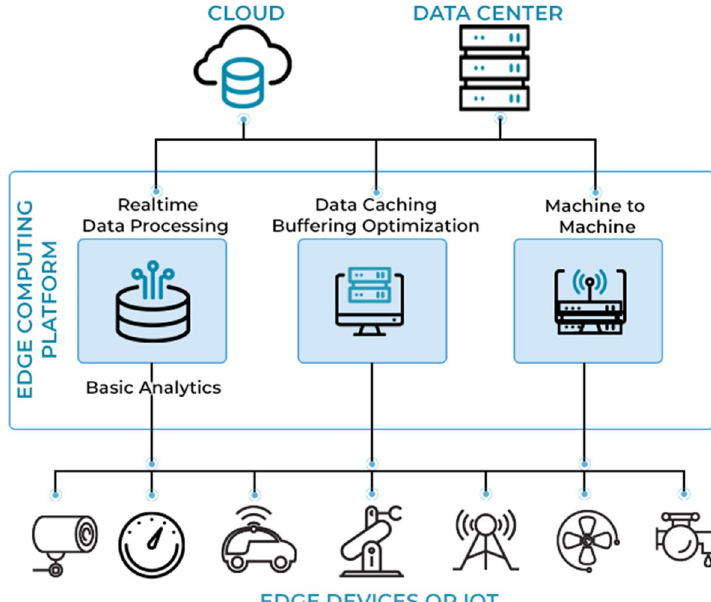
Fig. 7 An edge-cloud platform for distributed